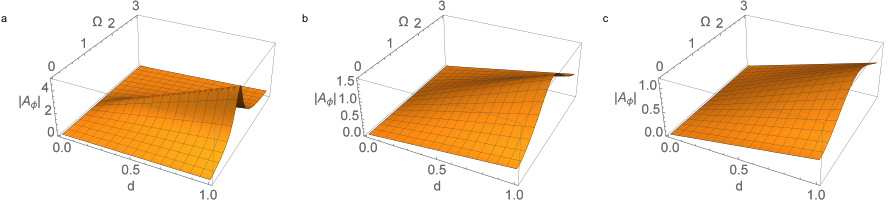
Figure 5. The amplitude of the forced oscillations of the pendulum | A ϕ ( d , Ω ) | according to (33) for values of the parameter γ , characterizing friction: ( a ) γ = 0.2; ( b ) γ = 1.1; and ( c ) γ = 1.9. The calculation was performed for σ = 1.5, α = 1.5, and ω = 1.2.